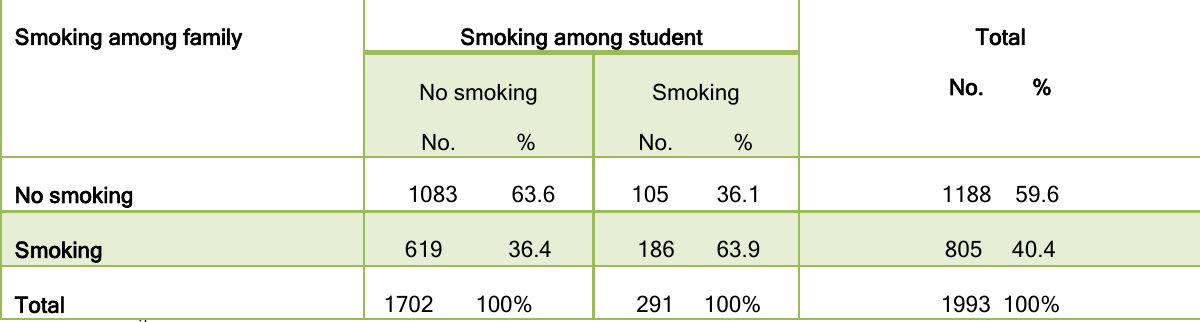
Table No. 2 showed strong association between smoking habit among family and the smoking prevalence among students the difference was statistically highly significance (P. value < 0.001). Table (2): The relation of smoking among family members and smoking among